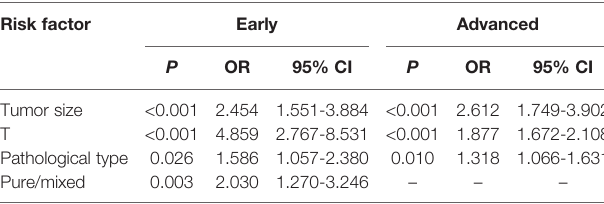
TABLE 2 | Multivariate analysis of the risk factors for lymph node metastasis in early and advanced gastric